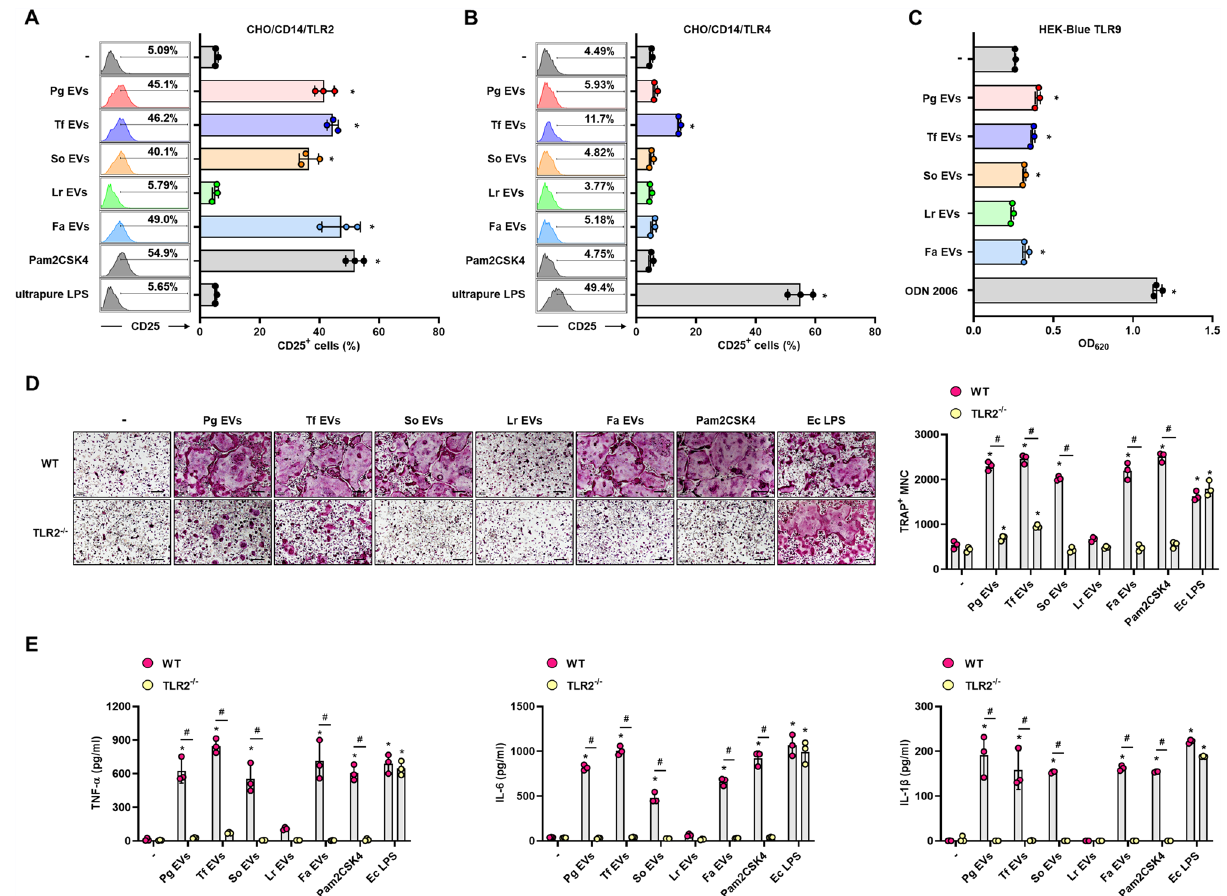
Figure 3. TLR2 activation by bacterial EVs in osteoclast precursors. ( A , B ) CHO/CD14/TLR2 or CHO/ CD14/TLR4 cells were stimulated with bacterial EVs (1 μg/ml EV protein) for 20 h. CD25 expression by TLR activation was measured by flow cytometry. Pam2CSK4 (100 ng/ml) and ultrapure E. coli LPS (100 ng/ml) were used as TLR2 and TLR4 ligands, respectively. ( C ) HEK-Blue TLR9 cells were stimulated with bacterial EVs (1 μg/ml EV protein) for 24 h. SEAP expression by TLR9 activation was measured by a spectrophotometer at 620 nm. ODN 2006 (1 μg/ml) was used as a TLR9 ligand. ( D ) WT and TLR2 −/− osteoclast precursors were stimulated with bacterial EVs (10 μg/ml EV protein) in the presence of M-CSF (30 ng/ml) for 3 days. The number of TRAP + mature osteoclasts was counted (right panel). The experiments were performed at least three times independently. The graphs show the mean values ± standard deviations of a representative experiment. ( E ) WT and TLR2 −/− osteoclast precursors were stimulated with bacterial EVs (10 μg/ml EV protein) in the presence of M-CSF (30 ng/ml) for 24 h. Osteoclastogenic cytokines (TNF-α, IL-6, and IL-1β) in the culture supernatants were measured by ELISA. Pam2CSK4 (1 μg/ml) and E. coli LPS (1 μg/ml) were used as positive controls. The experiments were performed at least three times independently. The graphs show the mean values ± standard deviations of a representative experiment. Statistical significance was determined by one-way ANOVA ( A , B , and C ) or by two-way ANOVA ( D , E ). * P < 0.05 compared with the nontreatment group ( −). # P < 0.05 compared with the indicated